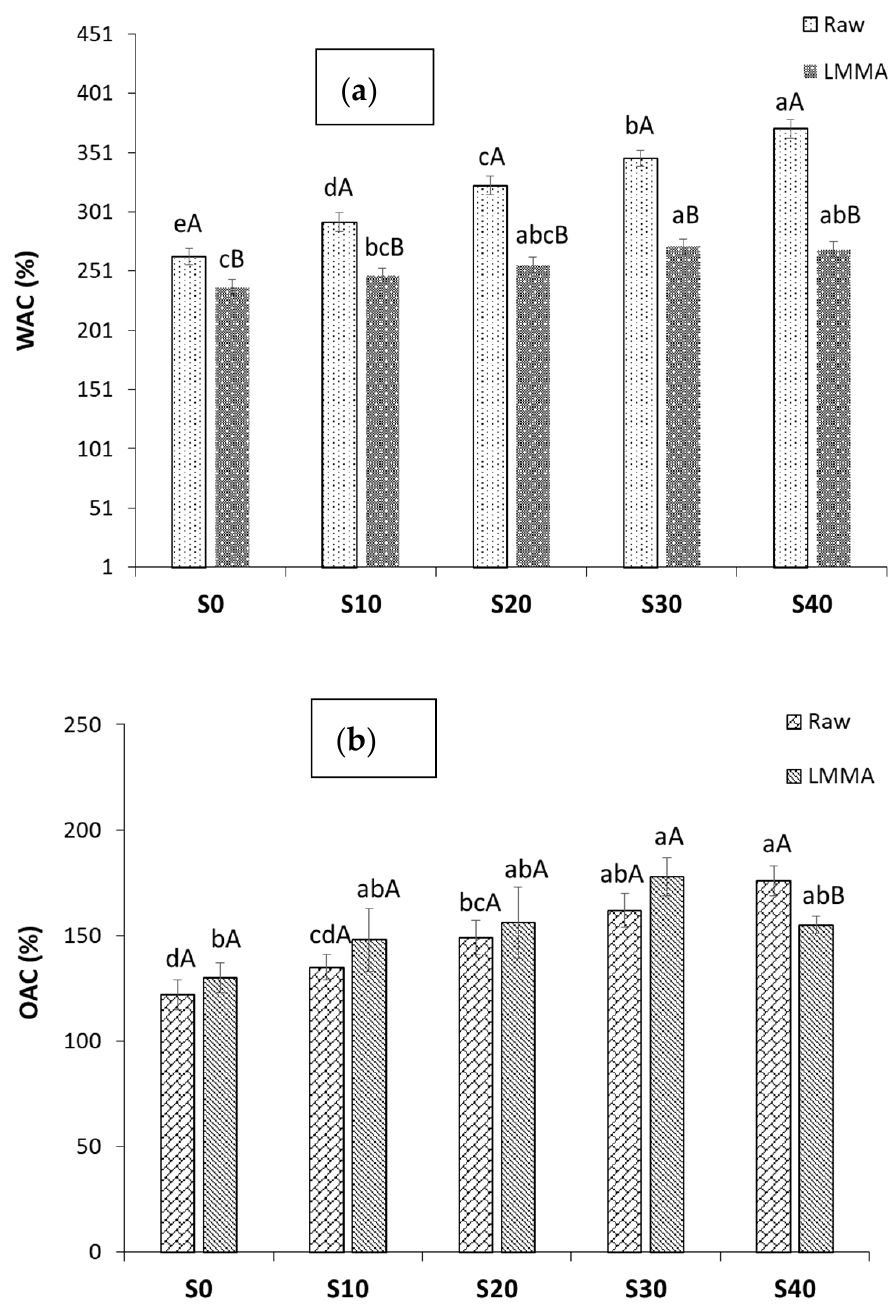
Figure 2. Effect of mycelium addition on ( a ) water absorption capacity, and ( b ) oil absorption capacity. All the values are mean ± SD ( n = 3). Different capital letters in the same formulation on the top of bar showed significant difference ( p < 0.05). Different lower case letters showed significant difference ( p < 0.05) between same type, i.e., raw or extruded .